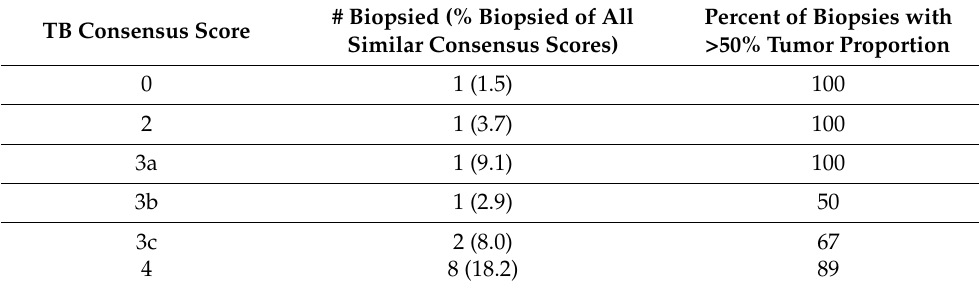
Table 4. Distribution of Re-biopsies by Score and Tumor